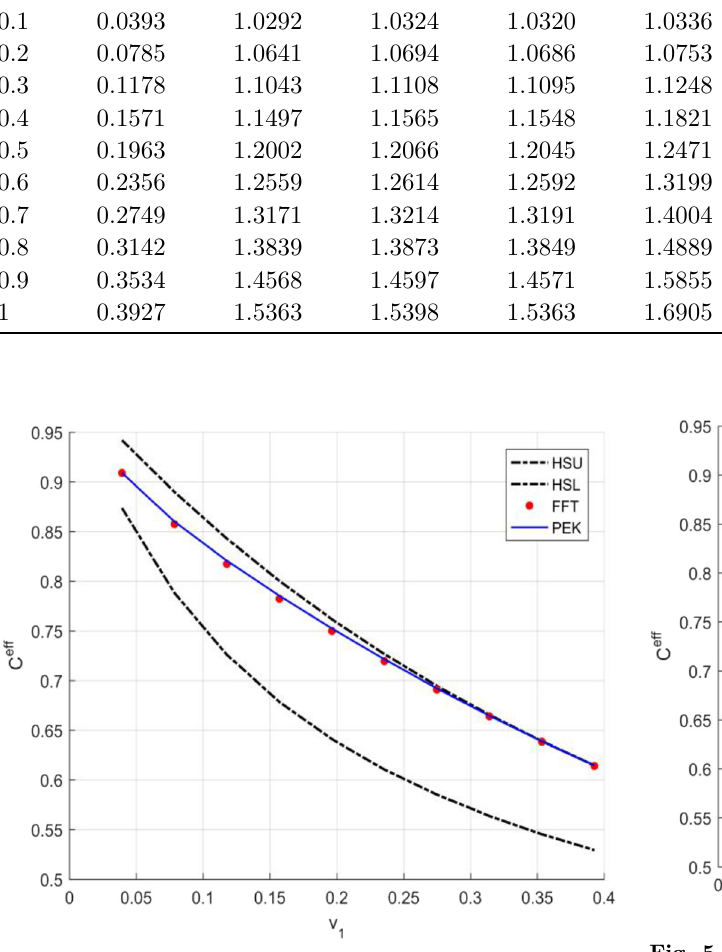
Fig. 4. Effective conductivity of square model with imperfect